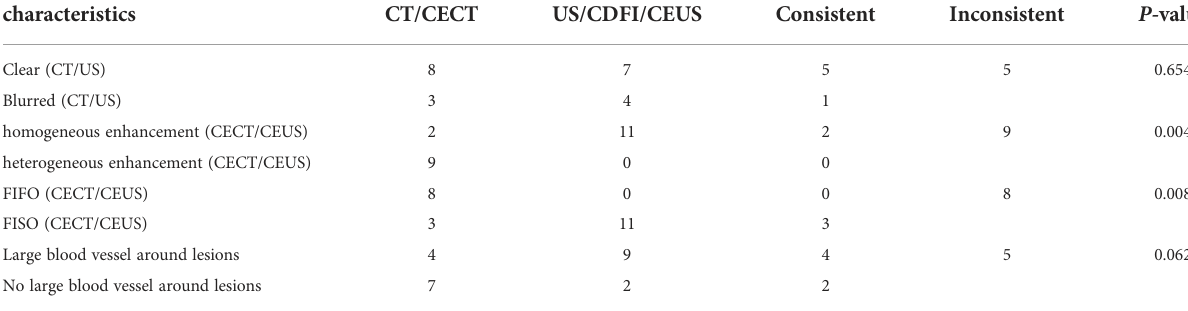
TABLE 4 Comparative analysis of CT/CECT and